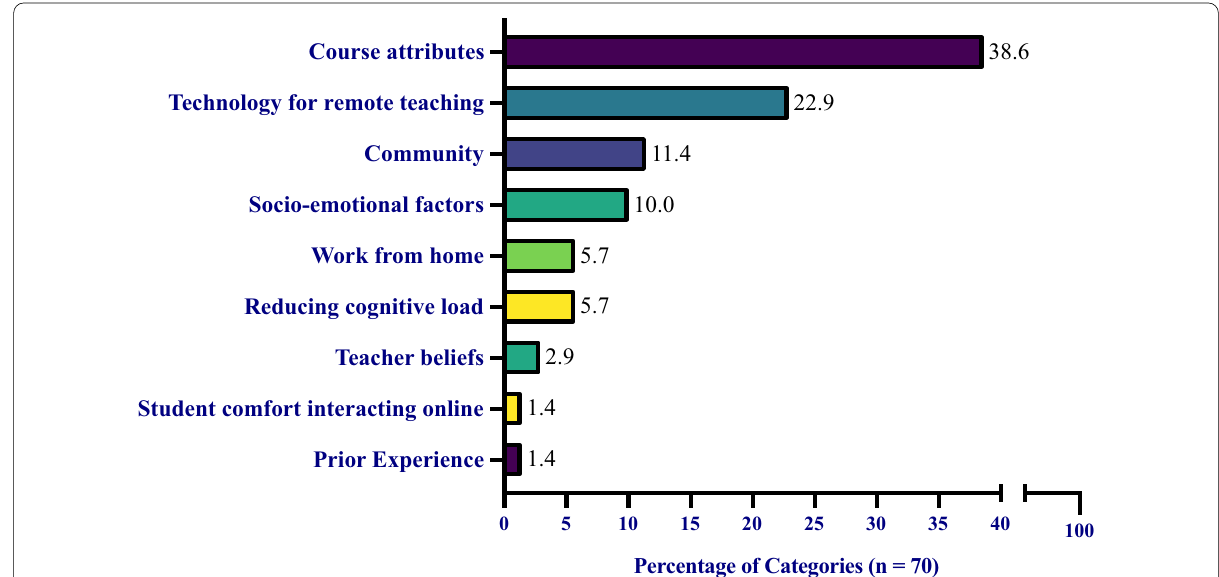
Fig. 4 Students’ perceived supports during their transition to ERT. The percentage of support categories from students. Each value is the total number of each category divided by the total number of all categories, 70. For example, ‘course attributes’ was mentioned 27 times and 27/70 38.6%. Note: no student used a single code more than =